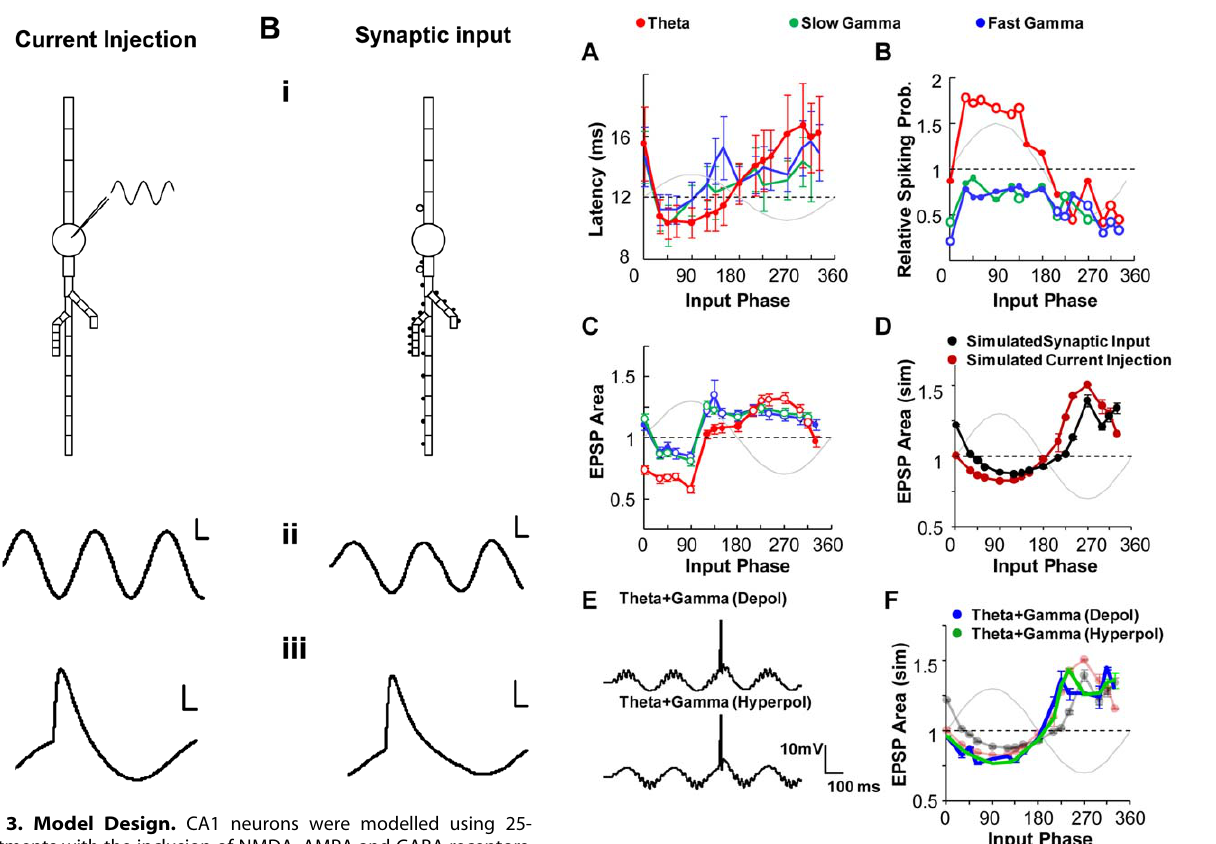
Figure 3. Model Design. CA1 neurons were modelled using 25- compartments with the inclusion of NMDA, AMPA and GABA receptors. Note that in the cell model schematics, the basal dendrites are positioned upward and the apical dendrites downward, consistent with typical recording configurations. ( A ) Theta frequency network activity simulated using sinusoidal current injection. This generated a sinusoidal response at the soma with a peak-to-peak membrane potential of , 10 mV (sub-panel ii, Scale bars represent 1 mV, 20 ms). Current injection was then given in combination with afferent synaptic input at 16 input phases. Example in sub-panel iii shows afferent inputs converging at an input phase of 90 degrees (Scale bars represent 2 mV, 10 ms). ( B ) Theta frequency network activity simulated using a patterned barrage of excitatory and inhibitory inputs. GABA inputs were clustered on the soma and on the most proximal apical and basal compartments (open circles). Glutamate and NMDA receptors were distributed throughout the apical dendrite including its branches (filled circles). Sub-panel ii shows the resulting sinusoidal theta frequency response measured at the soma (Scale bars represent 1 mV, 20 ms). Afferent synaptic inputs were then overlaid at 16 input phases. Example in sub-panel iii shows afferent inputs converging at an input phase of 90 degrees (Scale bars represent 2 mV, 10 ms). Somatic responses generated using current injection are comparable to those generated using a barrage of synaptic inputs.